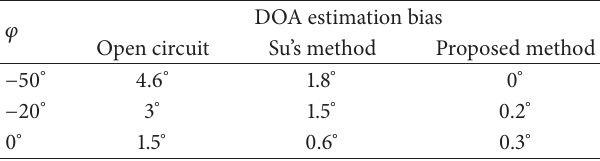
Table 3: DOA estimation bias for the circularly polarized array.